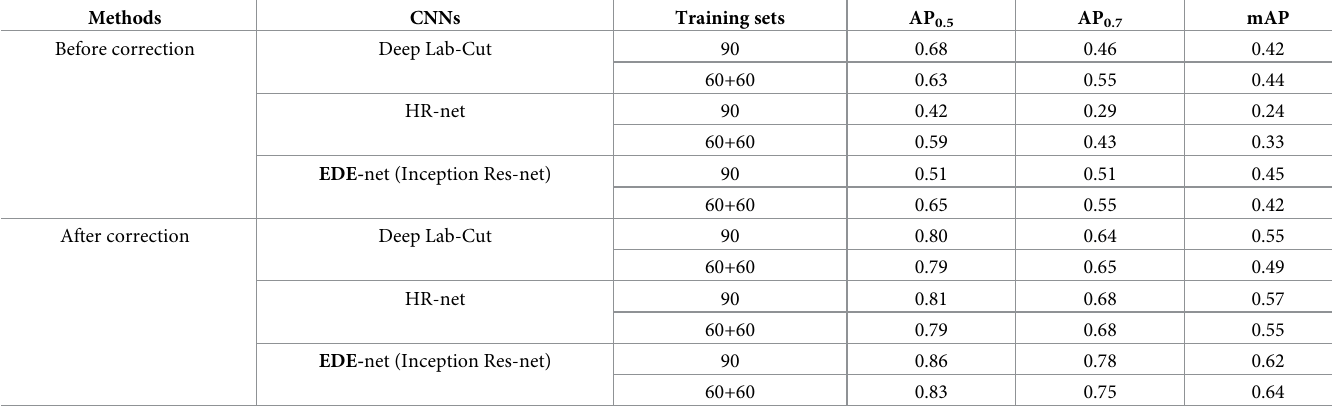
Table 5. AP results of feature points extracted from different